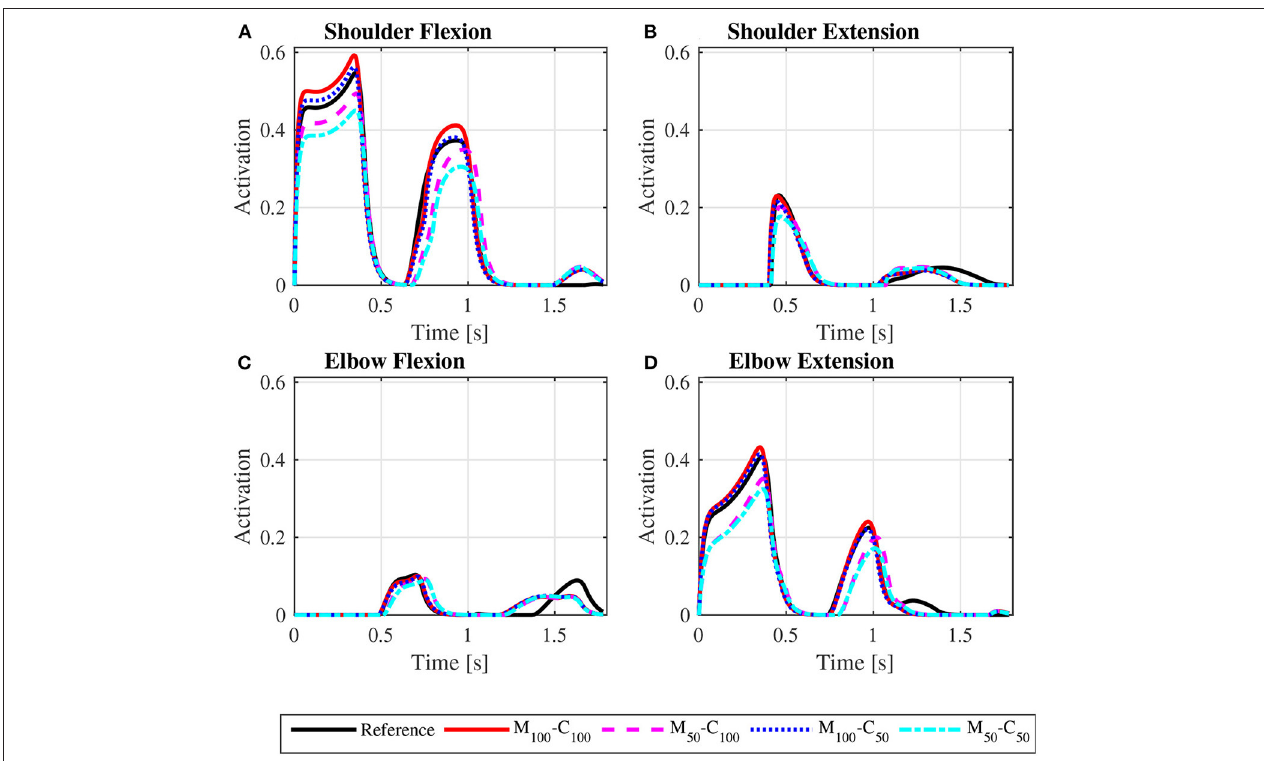
FIGURE 9 | Predicted shoulder flexion (A) , shoulder extension (B) , elbow flexion (C) , and elbow extension (D) activation profiles along the sequence of phases propulsion-recovery-propulsion-recovery-propulsion in the startup locomotion on a level surface at an average speed of 0.9 m/s for the reference unassisted condition (Reference), and for the assisted locomotion with 100% of reference model parameters M i and C i ( M 100 − C 100 ), reduction of 50% in M i ( M 50 − C 100 ), reduction of 50% in C